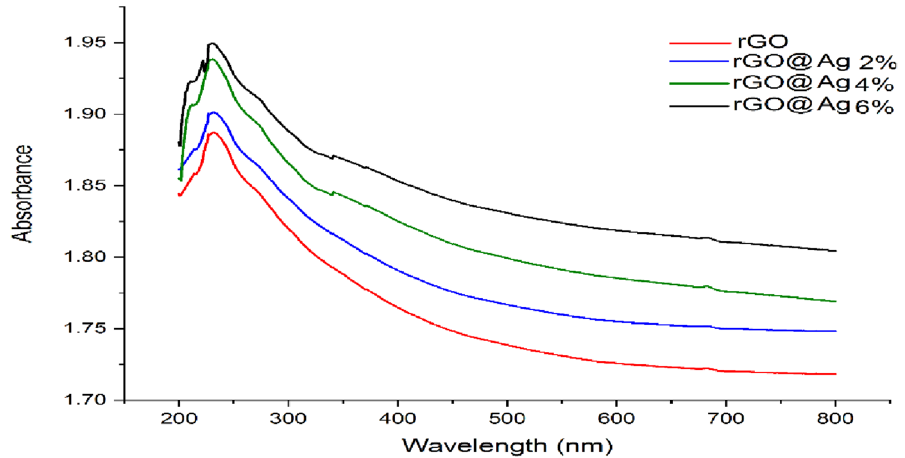
Fig. 1 UV—VIS spectra of as-synthesis rGO and rGO@Ag